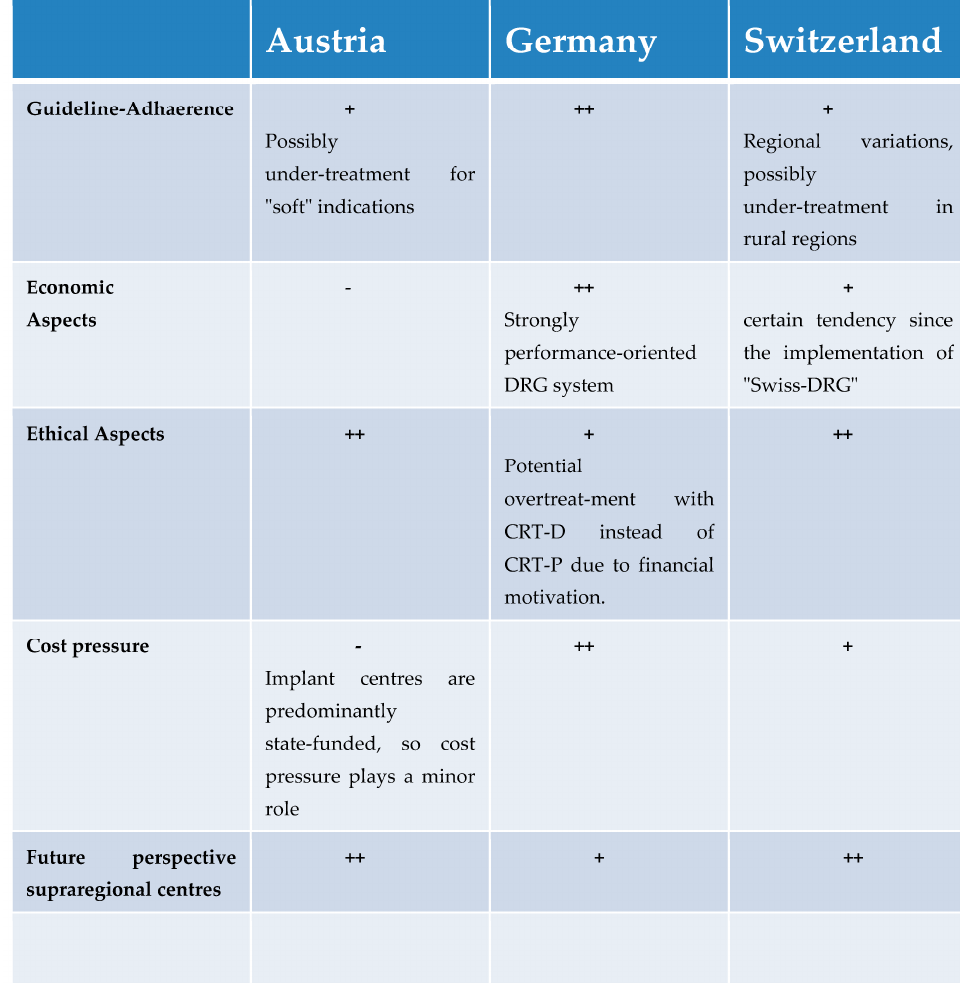
Figure 3. Schematic illustration of the most relevant answers. + = applies. ++ = strongly applies. - = applies